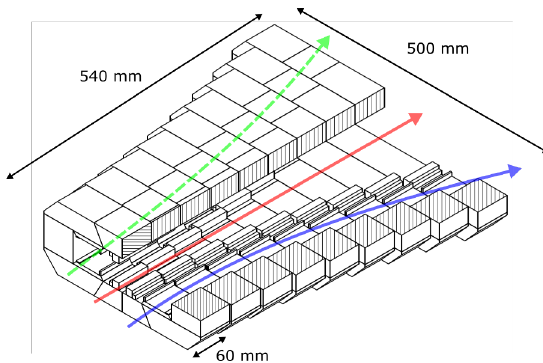
Figure 11. 3D layout of the septum magnet consisting of nine consecutive layers with 60mm thickness, each. The horizon- tal apertures of these layers increase according to the trajectory of the deflected beams. The total length of the septum will be 540mm with 500mm width at the end. The colored arrows in- dicate the trajectories of proton beams with di ff erent pulse struc- tures as presented in figure